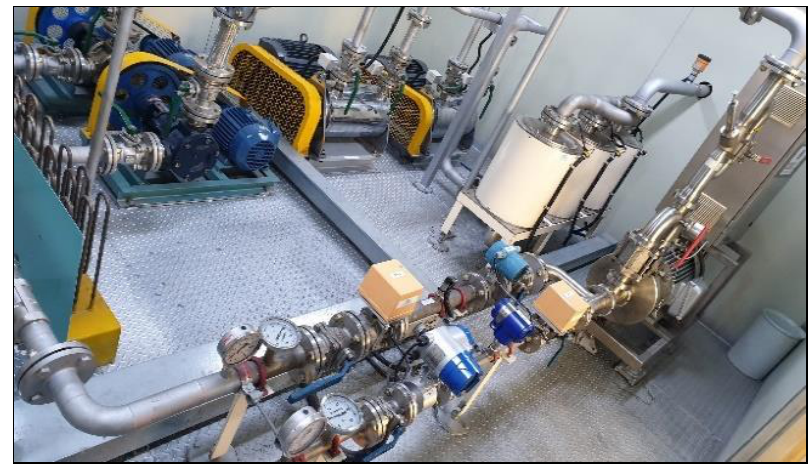
Figure 2. Photograph of emulsification equipment [21].